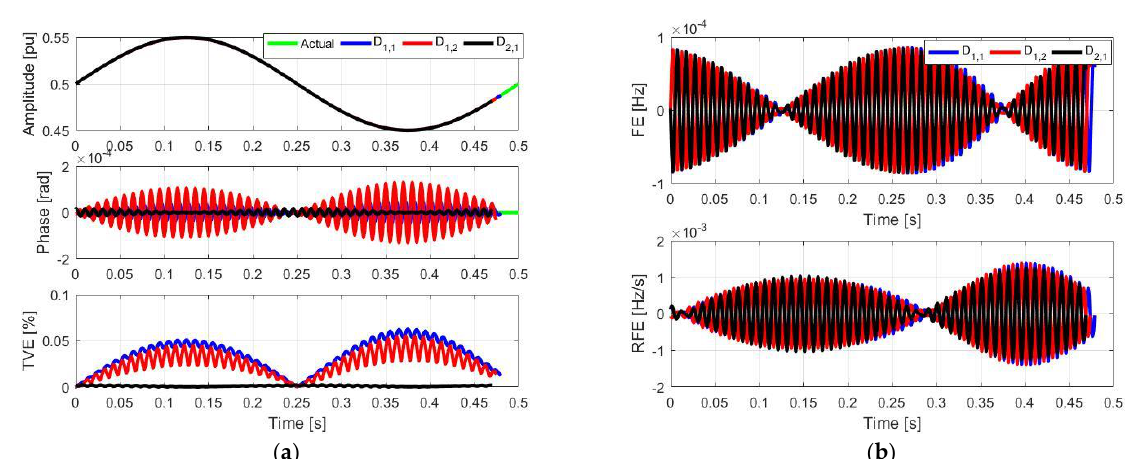
Figure 6. Simulation results obtained for the amplitude modulated signal with 𝑓 𝑚 = 2 Hz , for 𝐾 = 1 for 𝐷 1,1 = 16 and 𝐷 1,2 = 20 , and 𝐾 = 2 for 𝐷 2,1 = 24, with 𝑓 1 = 50 Hz and 𝑓 𝑆 = 800 Hz ( 𝑁 = 16 ): ( a ) amplitude, phase and TVE, and ( b ) FE and RFE.